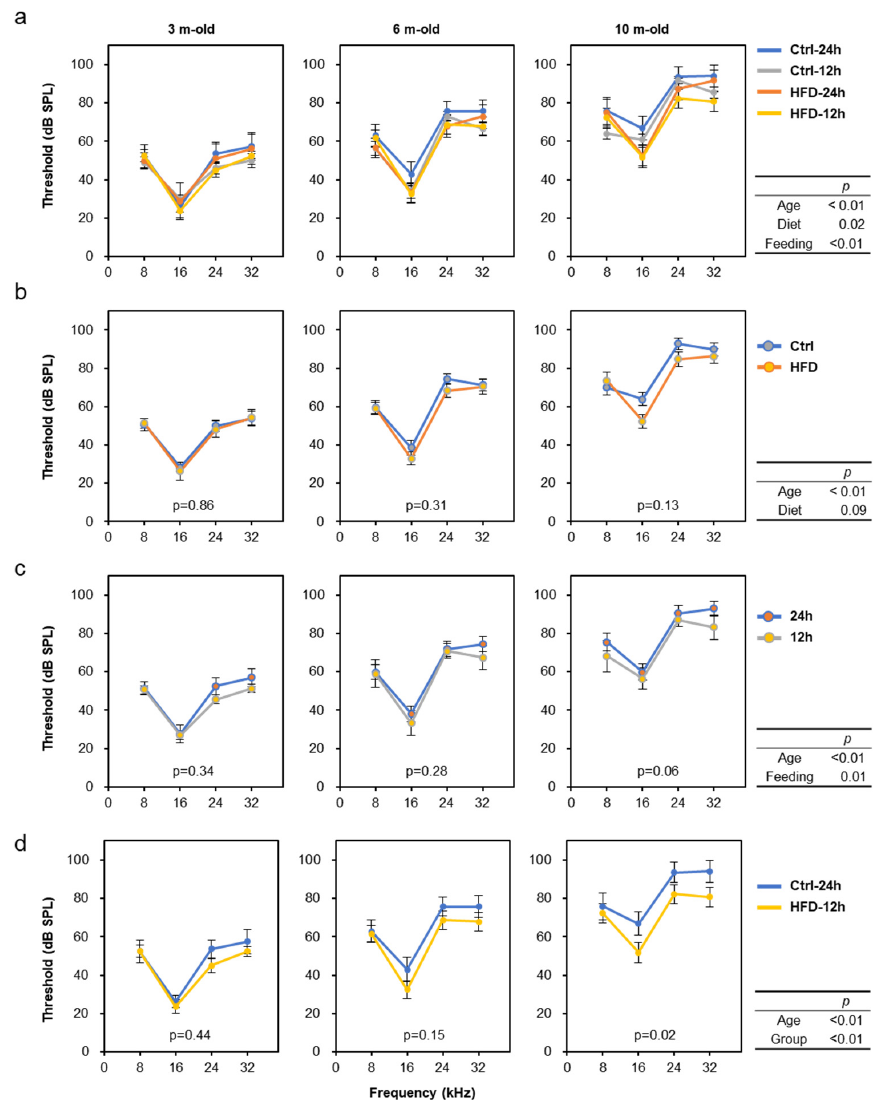
Figure 3. Age-related hearing decline and the nutritional e ff ects in SAMP8 mice: Auditory brainstem response (ABR) were measured about 8, 16, 24, and 32 kHz at the age of 2, 6, and 10 m-old (randomly selected 4 mice each at 2 m-old and all 11–12 mice each at 6 and 10 m-old). Hearing threshold was defined as the lowest stimulus intensity in 5 dB steps. Data is shown by group ( a ), diet ( b ), feeding ( c ), and comparison of the two groups with the greatest difference in hearing at 10 months of age ( d ; Ctrl ‐ 24 h vs. HFD ‐ 12 h). The statistical p ‐ values of multi ‐ way repeated measures ANOVA are shown in the right table of each row, and the p ‐ values by comparing one condition within each graph by one ‐ way repeated measures ANOVA are shown in the figures.